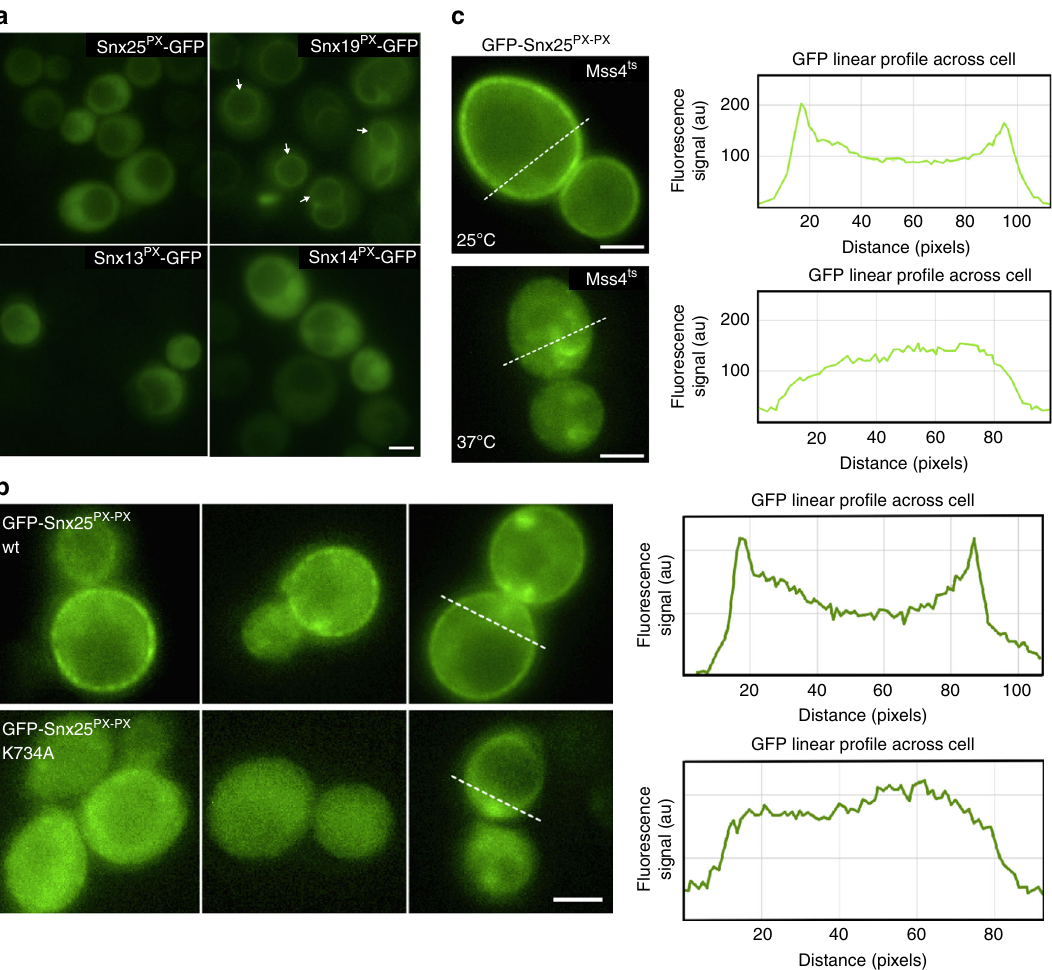
Fig. 6 The SNX25 PX domain is recruited to the plasma membrane via PtdIns(4,5) P 2 interaction. a GFP-tagged PX domains from human SNX25, SNX13, SNX14, and SNX19 were expressed in S. cerevisiae and their localization examined by confocal fl uorescence microscopy. Using single PX domains, only SNX19 shows membrane recruitment to the PtdIns3 P -enriched vacuole. White arrows indicate examples of the vacuolar recruitment of the SNX19 PX domain. b The tandem GFP-SNX25 PX-PX construct is recruited to the plasma membrane in yeast. This localization is blocked by the K734A